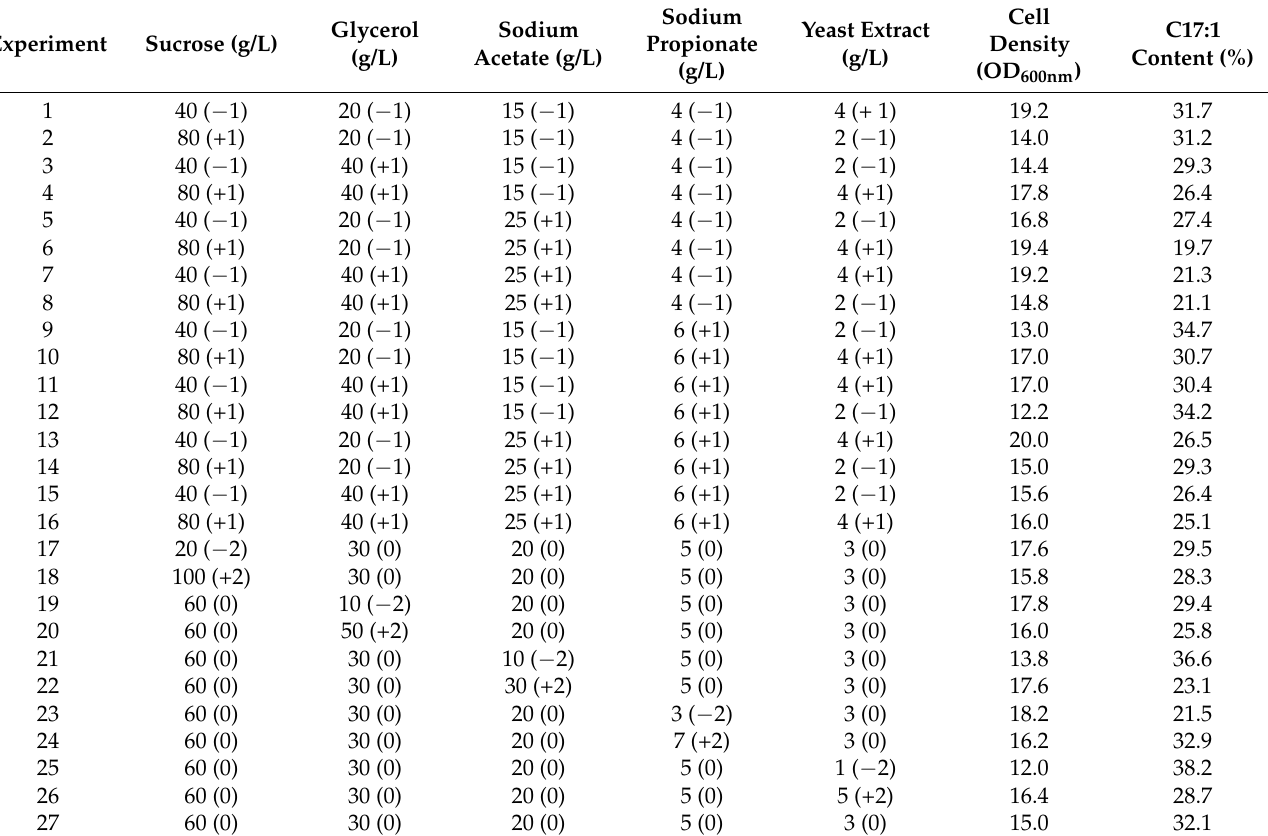
Table 3. Experimental plan and measured responses. Coded variables are provided in